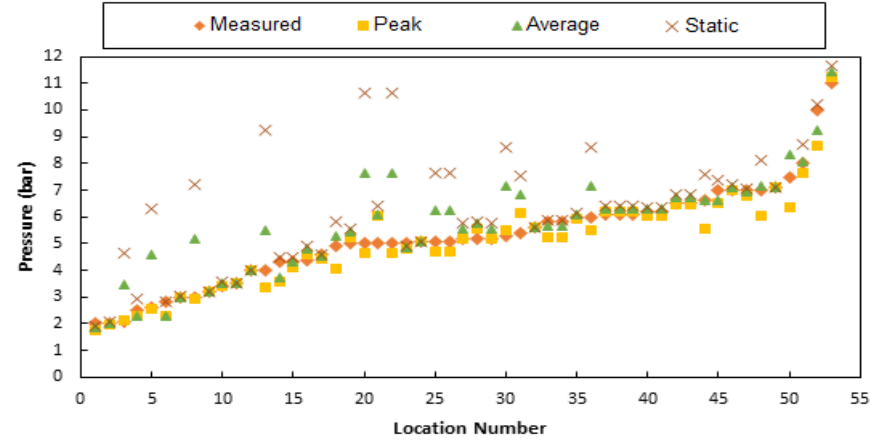
Figure 8. Measured and simulated pressure